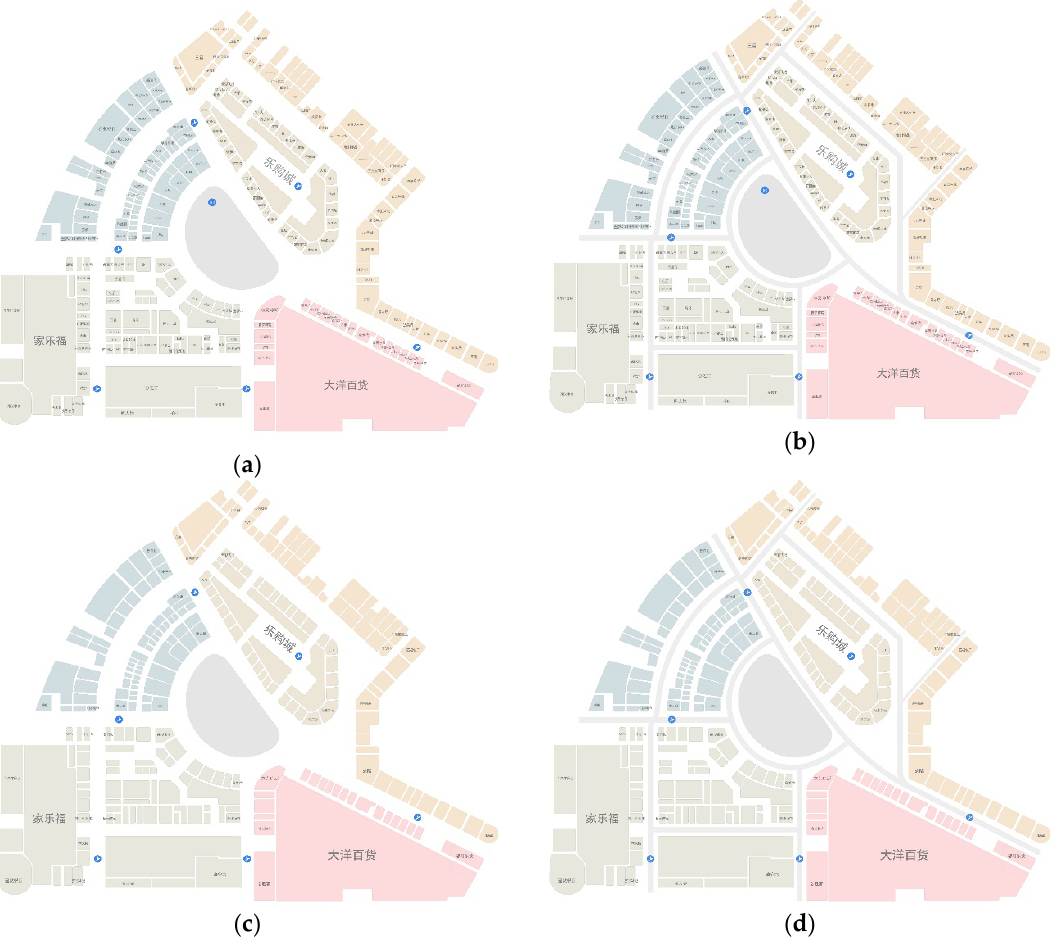
Figure 3. ( a ) The full-landmark map without highlighted paths, ( b ) the full-landmark map with highlighted paths, ( c ) the key-landmark map without highlighted paths and ( d ) the key-landmark map with highlighted paths.